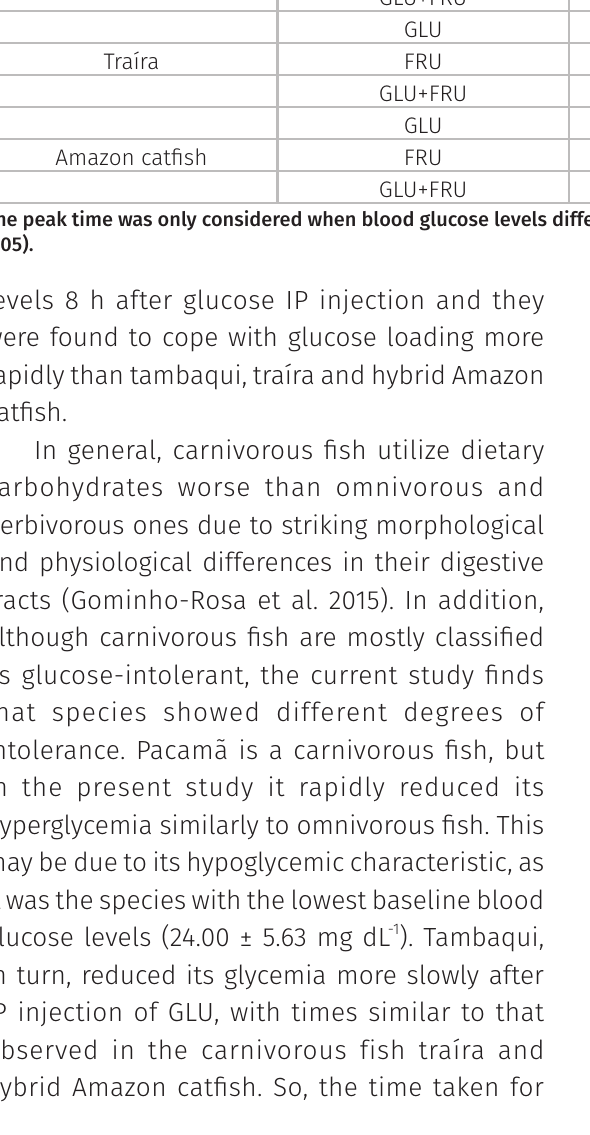
The peak time was only considered when blood glucose levels differed significantly from baseline time (0 h) (Dunnett’s test: p